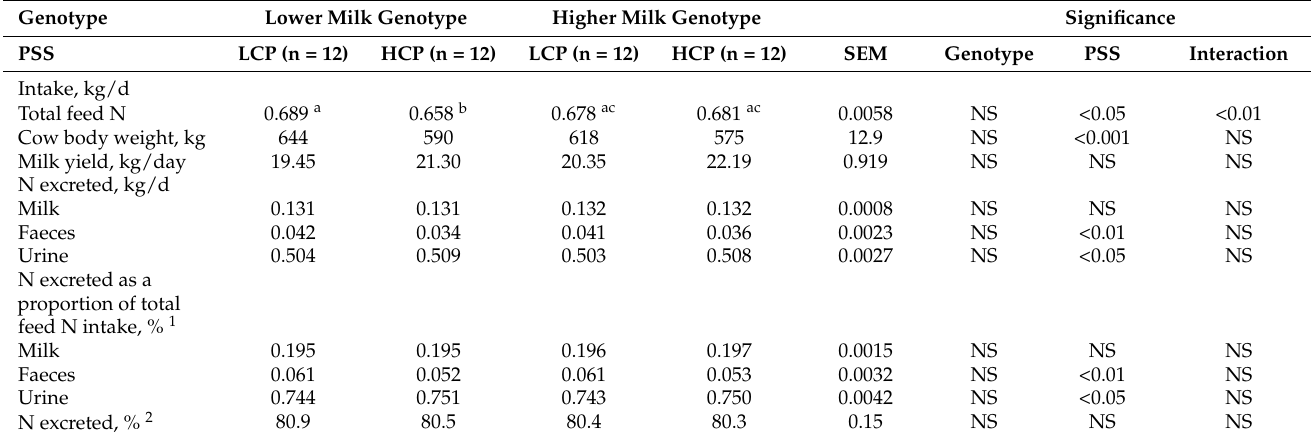
Table 5. Effects of protein supplementation strategy (PSS) and genotype on nitrogen (N) partitioning.